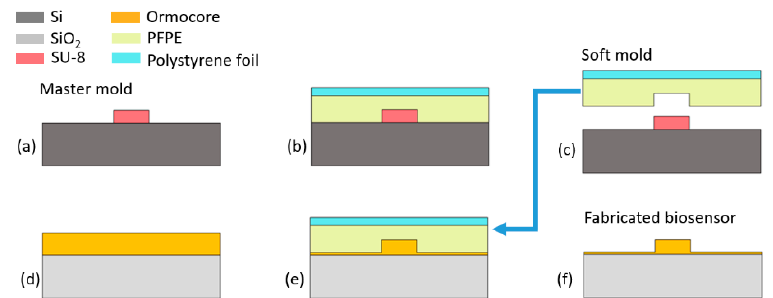
Figure 3. Fabrication process of the polytetrafluoroethylene (PFPE) soft mode ( a – c ) and UV-based soft imprinting process ( d – f ).